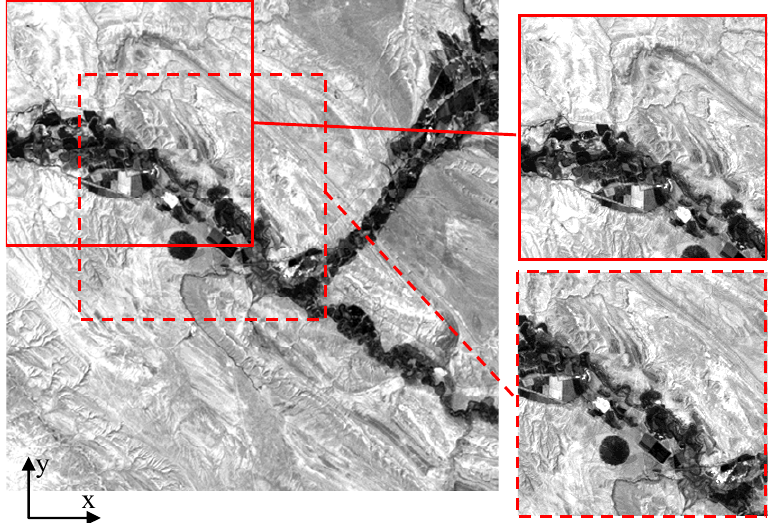
Figure 4. 512 × 512 pixel image used for testing of the mosaicing algorithm; an example is shown of a pair of sub-images employed for the algorithm test.